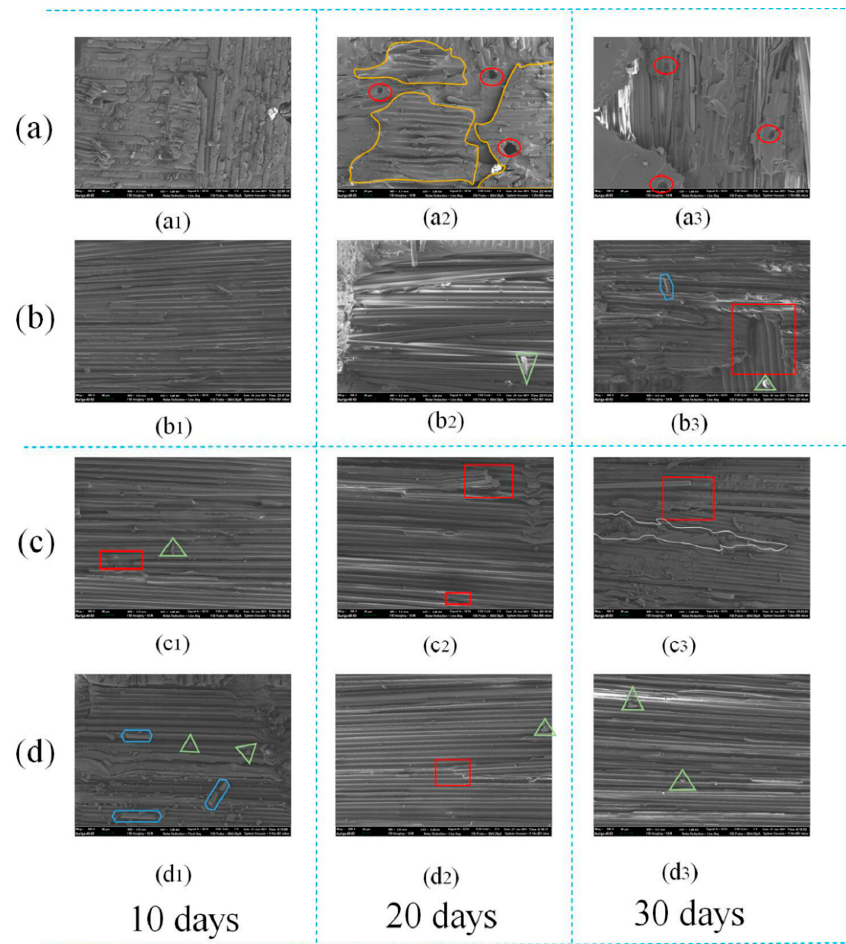
Figure 13. The SEM micrograph of different adhesive joints in different environments: ( a ) A2012 joints in 80 °C/95% RH, ( b ) A2012 joints in 80 °C/pure water, ( c ) A2015 joints in 80 °C/95% RH, and ( d ) A2015 joints in 80 °C/pure water.